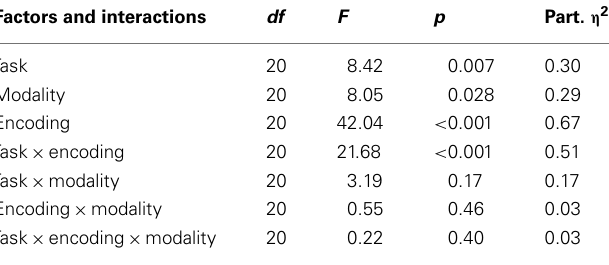
Table 1 | Summary of all theANOVA